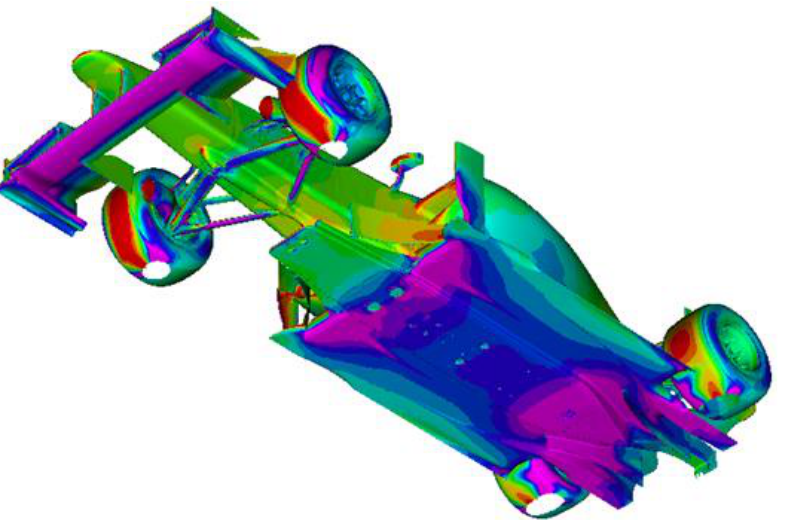
Figure 5. Pressure coefficient Cp under the car, showing main downforce contributions through ground effect.